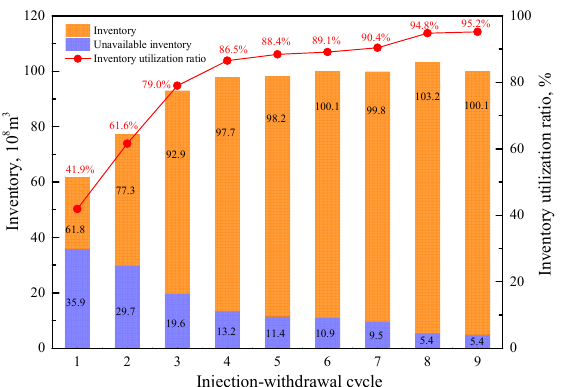
Figure 12. Inventory, unavailable inventory, and inventory utilization ratio variation trend in Hutubi UGS during nine injection − withdrawal cycles.